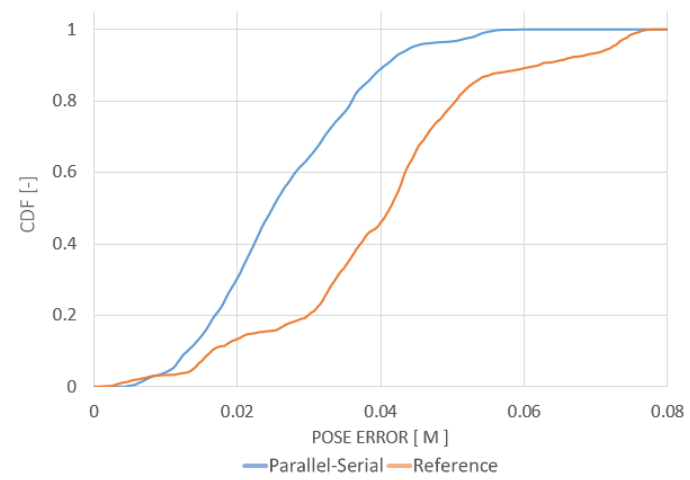
Figure 11. CDF of the position error relative to the ground-truth path with parallel-serial localization on the path projected in Figure 8. The orange line shows the reference localization algorithm results from [66], while the blue line shows the results of our